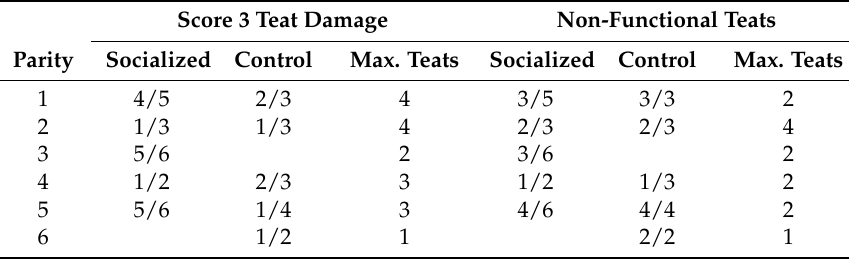
Figure 2. Average score for teat damage of the sow by treatment group (socialized: SOC; control: CON) before socialization (D14), 24h after socialization (D15), and at weaning (D26). n = 64. * Means differ by p < 0.05. Table 2. Number of sows (/out of total number per group) with at least one teat with score 3 at weaning or at least one non-functional teat at weaning, for sows in the socialized and control group by parity. Max. teats gives the maximum number of affected teats per sow by parity.